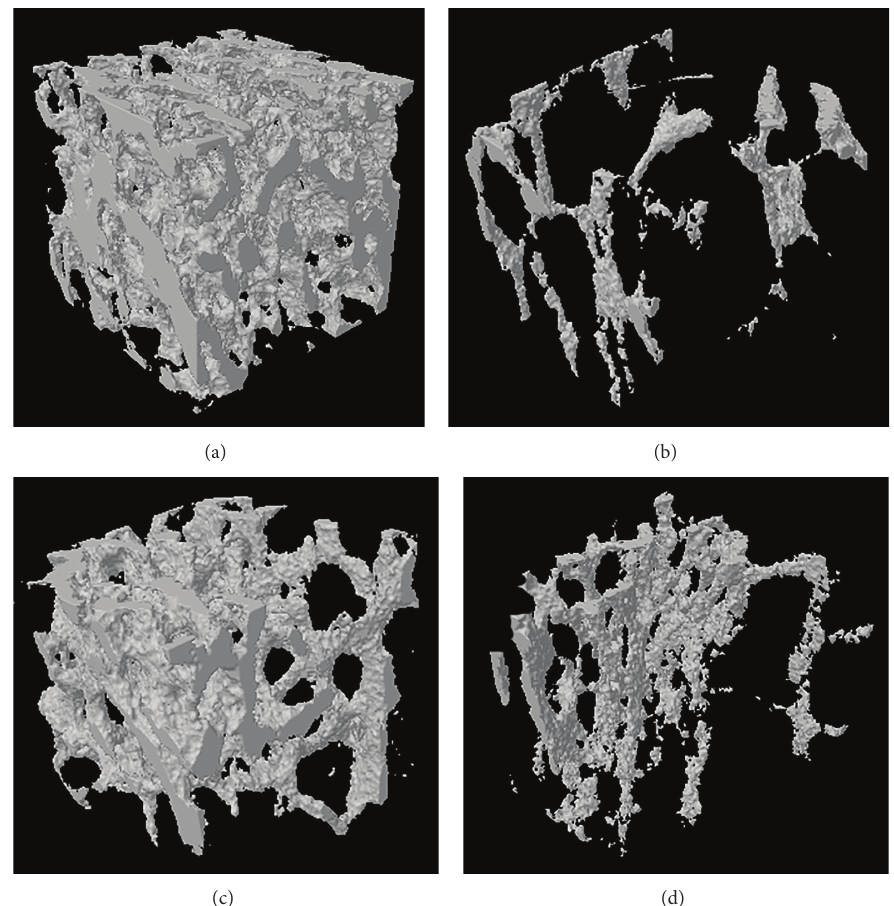
Figure 3: Representative sample from each group ( 𝑛 = 12 in each group): the 3D architecture of the trabecula bone beneath the tibial growth plate. (a) SHAM; (b) OVX; (c) E2; (d)